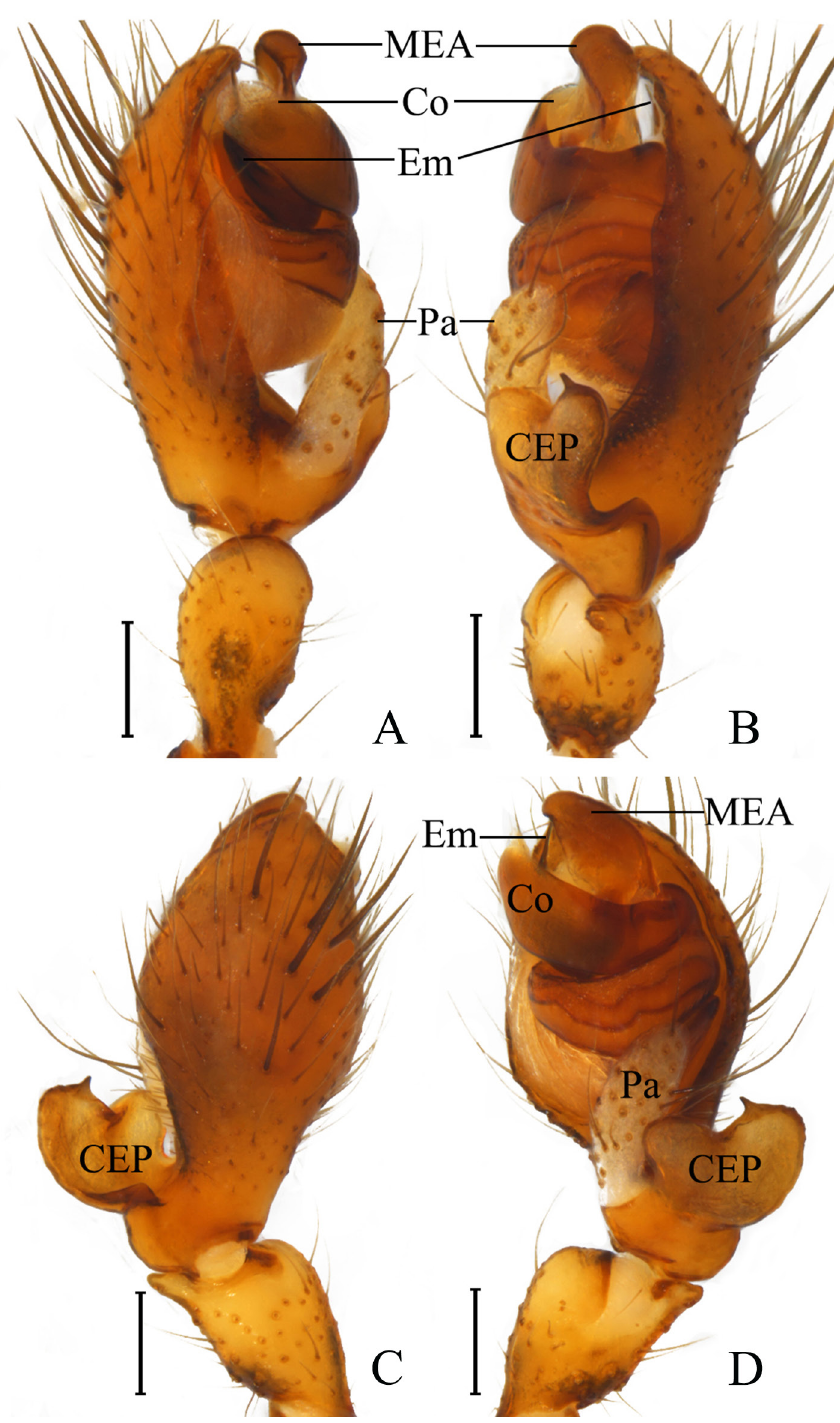
Fig. 13. Meta yinae sp. nov. Left palp of holotype ♂ (HNU-Tang-05-08). A . Prolateral view. B . Retrolateral view. C . Dorsal view. D . Ventral view. Scale bars: 0.2